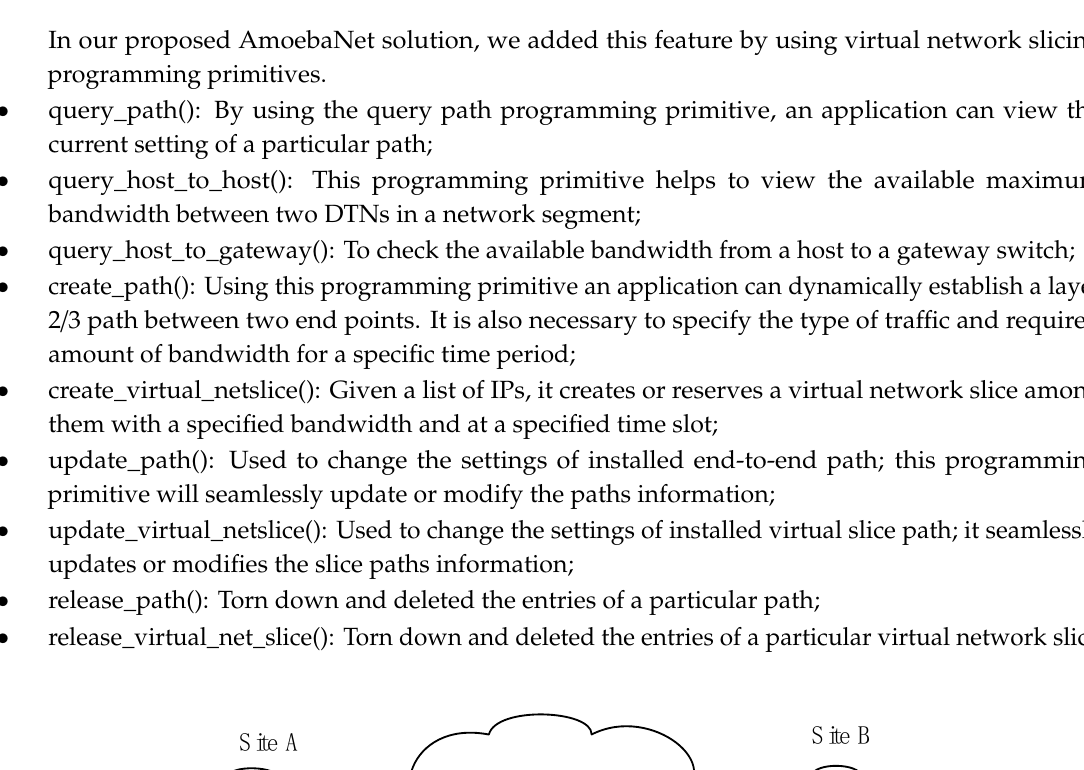
Figure 1. Architecture of the AmoebaNet solution.